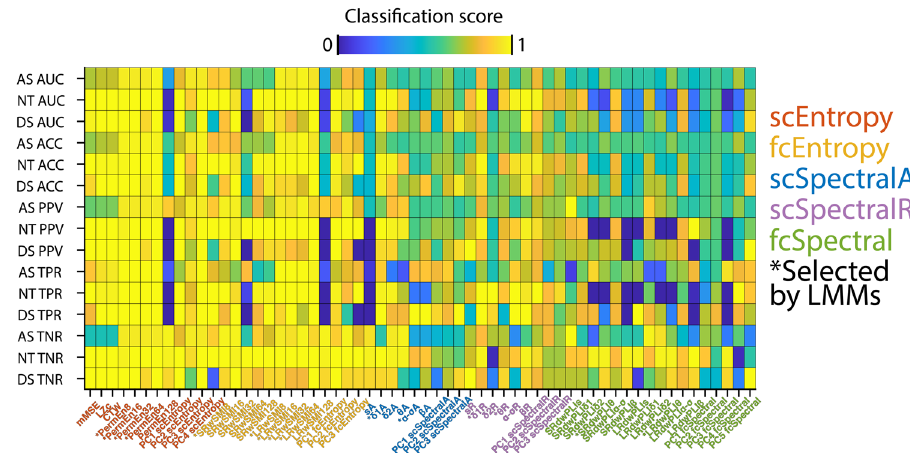
Fig. 4 Unregularized logistic regression univariate classi fi er performance for all channel-averaged variables. Model fi tting was performed without regularization for univariate classi fi cation. AUC area under ROC curve, ACC accuracy, PPV positive predictive value (precision), TPR true positive rate (recall or sensitivity), TNR true negative rate (speci fi city). Asterisks denote features selected using LMMs. Source data are presented in Supplementary Data 3. Table 3 Comparison of areas under the curve (AUC) of receiver operating characteristic plots for entropy versus spectral